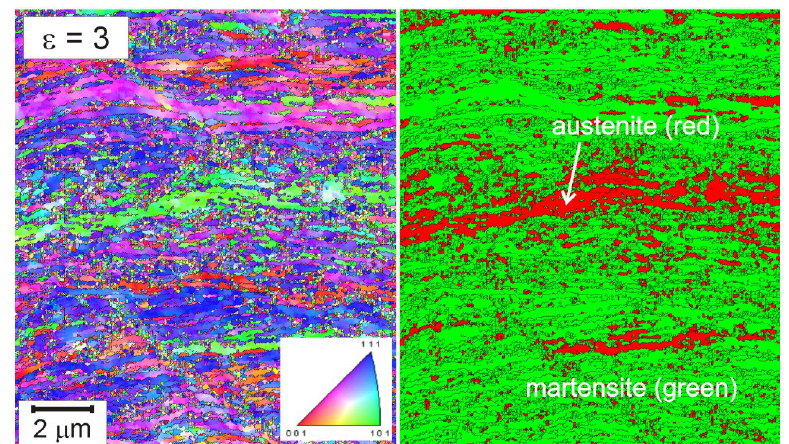
Figure 2. Deformation microstructures evolved in a 304L stainless steel during cold rolling various strains (ε). The black and white lines indicate the high-angle boundaries and twin boundaries, respectively. The inverse pole figures are shown for the normal